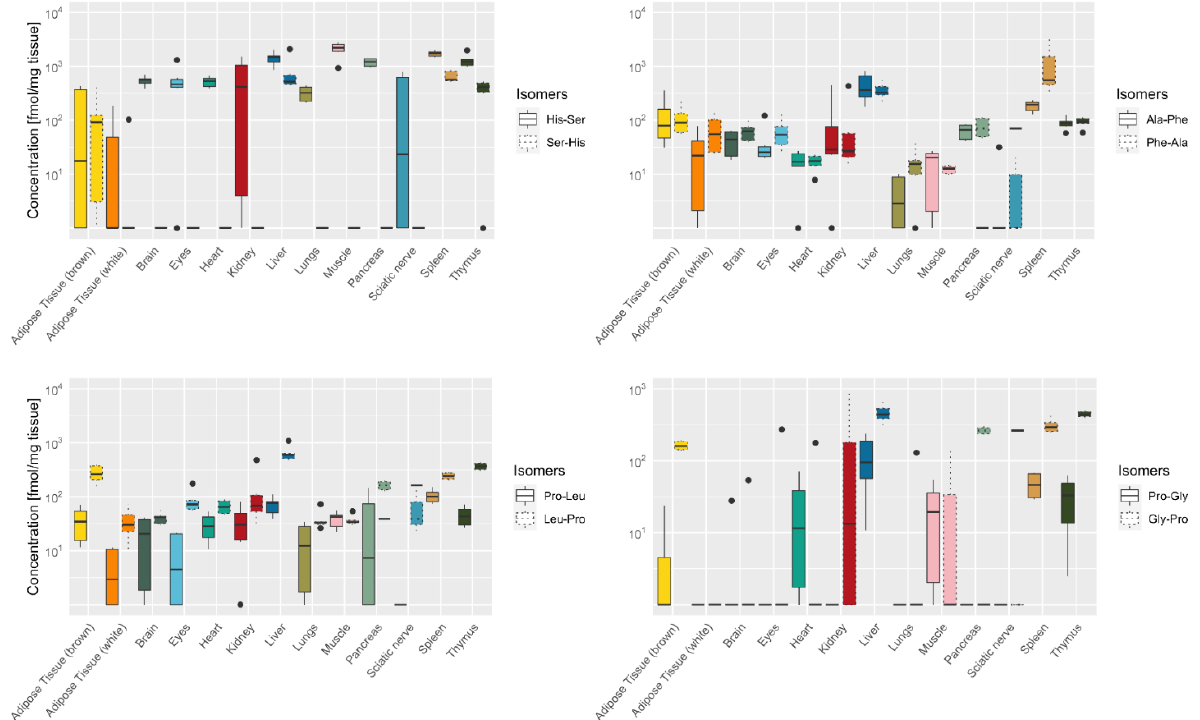
Figure 6. Distribution of four stereoisomeric dipeptides in murine tissue. Box plot showing the organ-specific concentration of four structural isomers (Ala-Phe/Phe-Ala; His-Ser/Ser-His; Pro-Leu/Leu-Pro; Gly-Pro/Pro-Gly), showing median as a bold line with standard deviation and • indicating outliers ( n = 6).